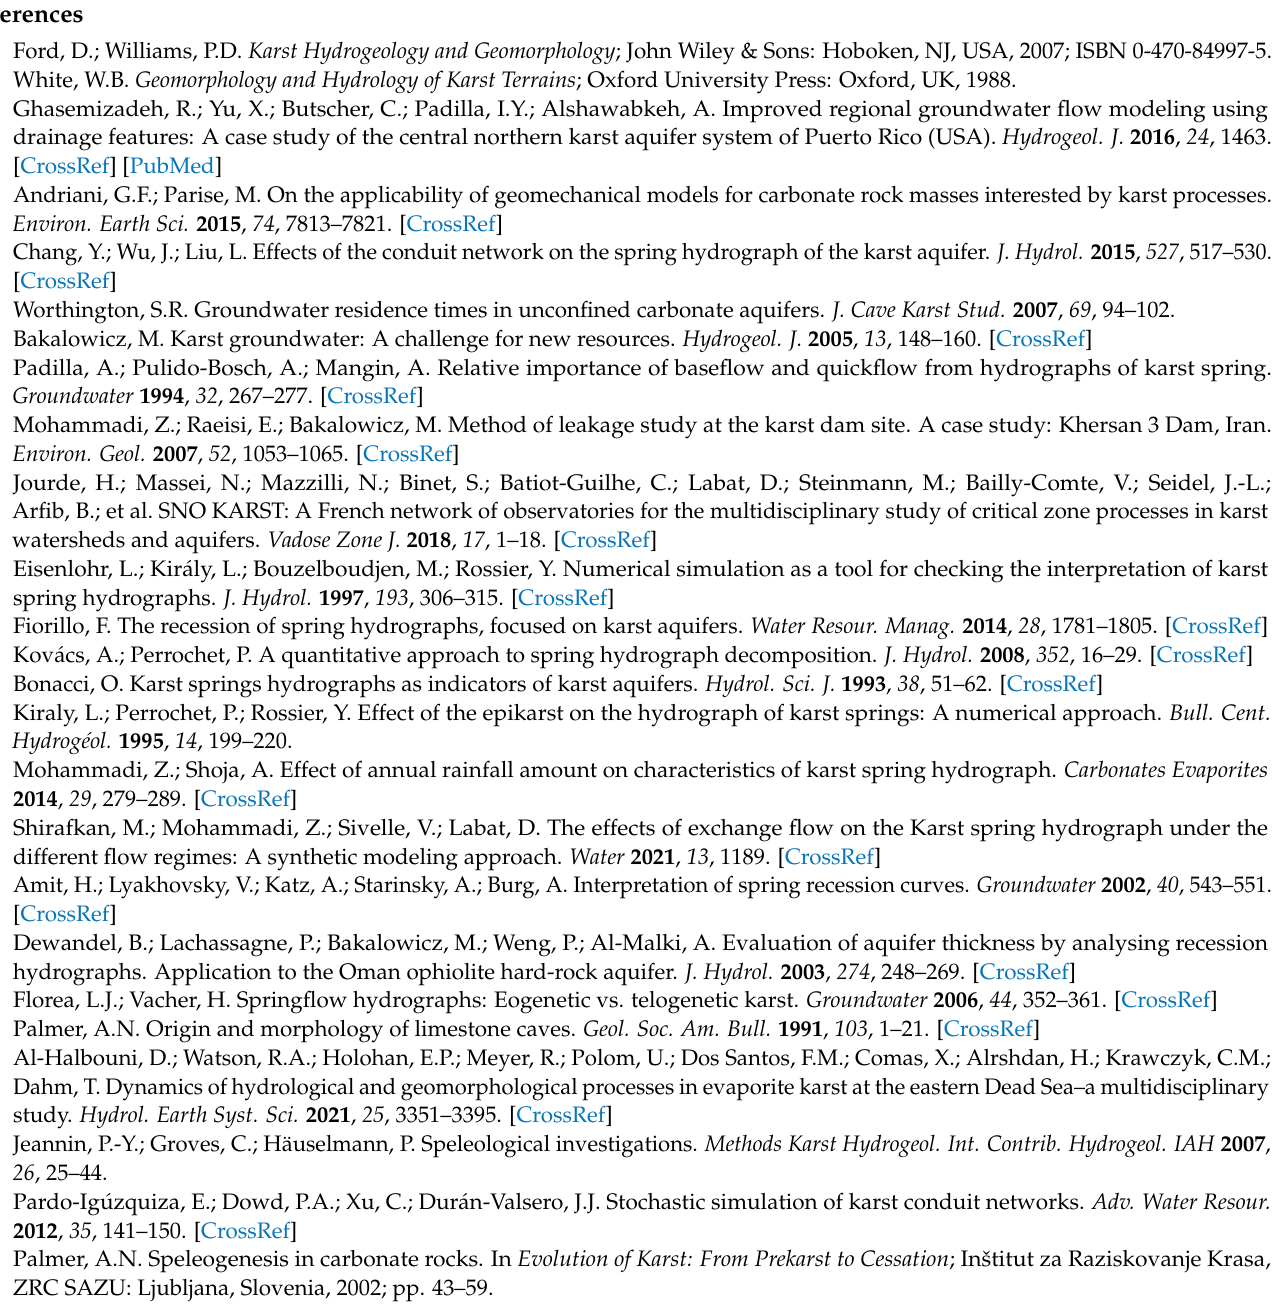
Table S2: The characteristics of the spring hydrograph in scenario B; Table S3: The characteristics of the spring hydrograph in scenario